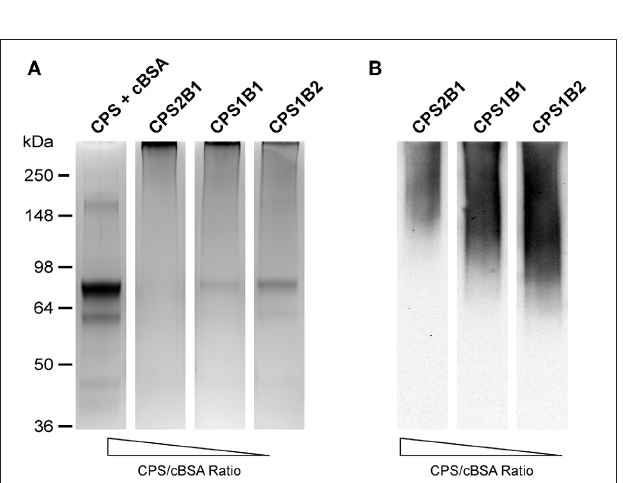
FIGURE 3 | Generalized scheme for the conjugation of activated B. pseudomallei CPS to carrier proteins.